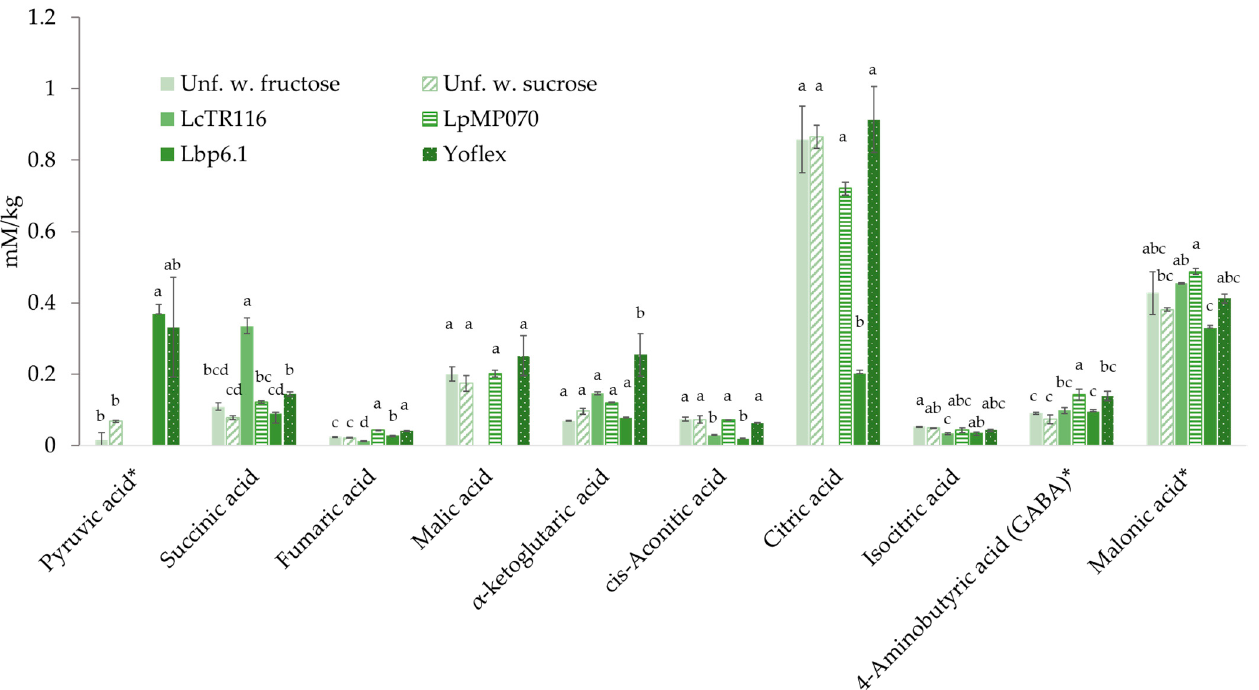
Figure 7. Several metabolites of the tricarboxylic acid cycle in the unfermented and fermented samples as measured by GC-MS. Error bars indicate the standard deviation. Values for each metabolite with the same superscript letters are not significantly different ( p > 0.05). * Relative quantification, values are normalized peak areas.